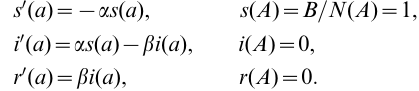
Figure 2. T. gondii ELISA results for wild boar. Frequency distribution of observed log 10 -transformed ODc-values in T. gondii ELISA for wild boar up to 20 months of age (n=722) (bins), distributions fitted using the binormal mixture model (lines), and cut-off value (logODc= 2 0.685) (vertical dashed line).